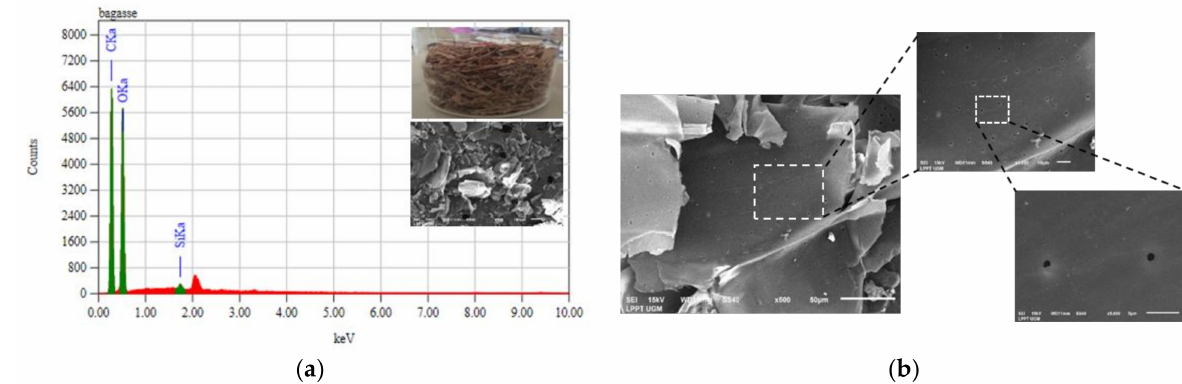
Figure 1. ( a ) EDX result of bagasse along with its optical and SEM images and ( b ) the higher magnification of SEM images.